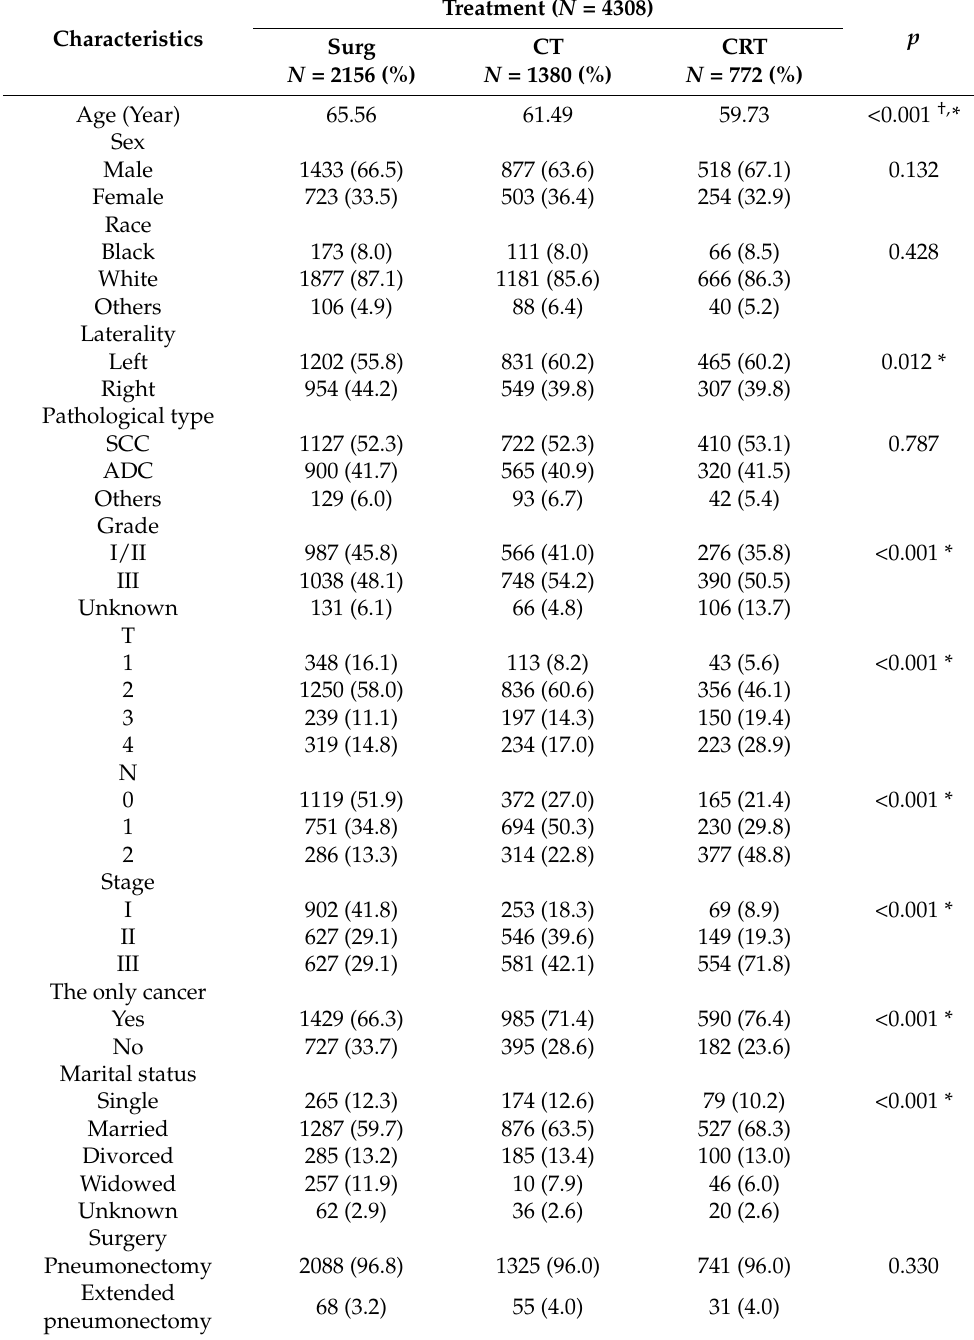
Table 1. Baseline characteristics of patients who underwent pneumonectomy for non–small-cell lung